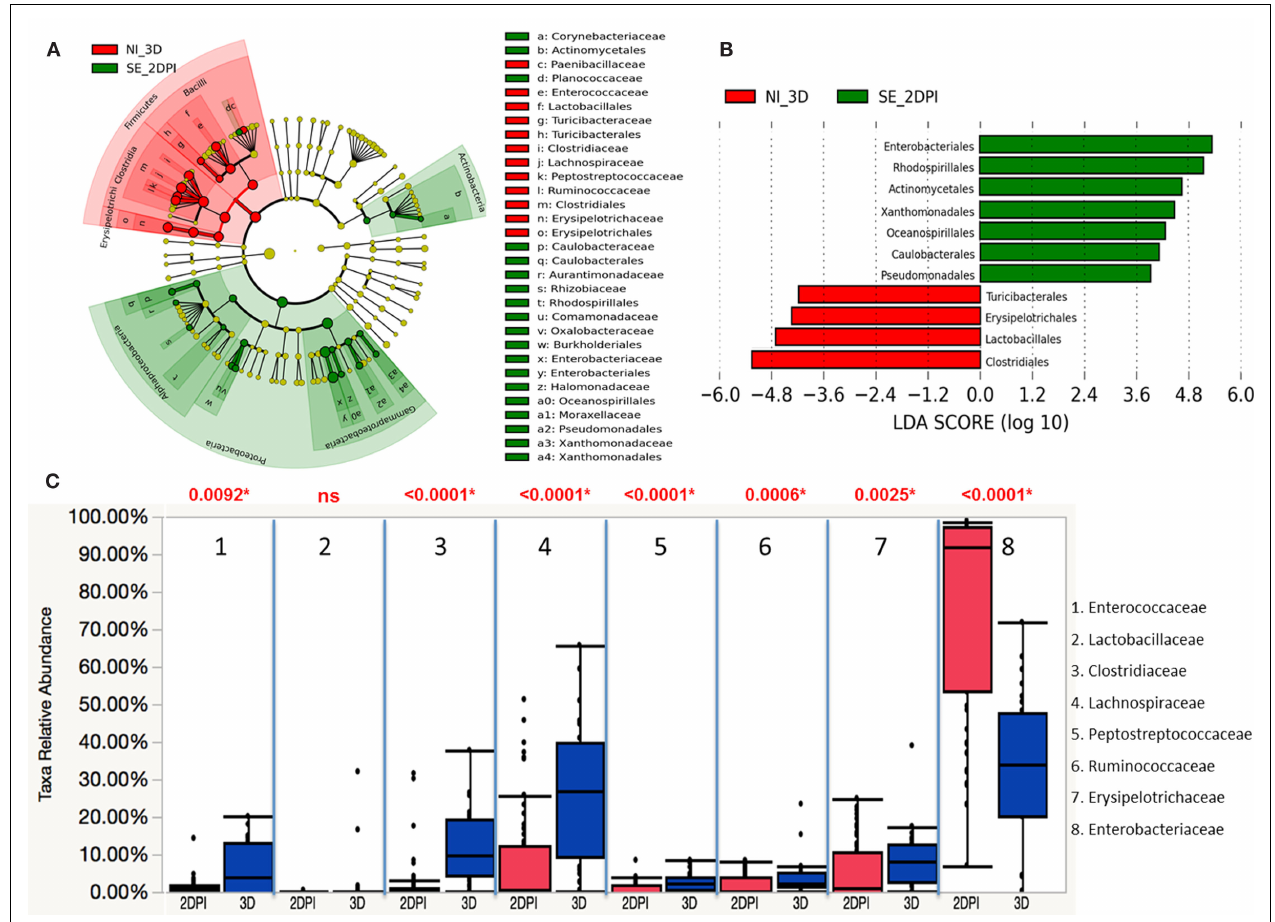
FIGURE 11 | Differential abundances of cecal microbial communities between infected and non-infected group at 2DPI . (A) Taxonomic cladogram generated from LefSe analysis showing significant difference in microbiota profile of non-infected (red) and S. Enteritidis-infected (green) at early days post infection (2DPI). (B) Differently abundant taxa detected with cut-off value of linear discriminant analysis (LDA) score > 2.0. Non-infected enriched taxa are indicated with negative LDA score (red) and taxa enriched in S. Enteritidis-infected have positive LDA score (green). (C) Comparison of relative abundance levels of cecal microbiota at family level in treatment group was evaluated. The boxplot shows the quartiles above and below the median with dark line at center of the box denoting median, black dots showing the outlier. The respective p value for each family group is reported using Wilcoxon rank sum test. Abbreviation: NI_3D, non-infected chicks at 3 days old; SE_2DPI, S. Enteritidis-infected chicks at 2 days post